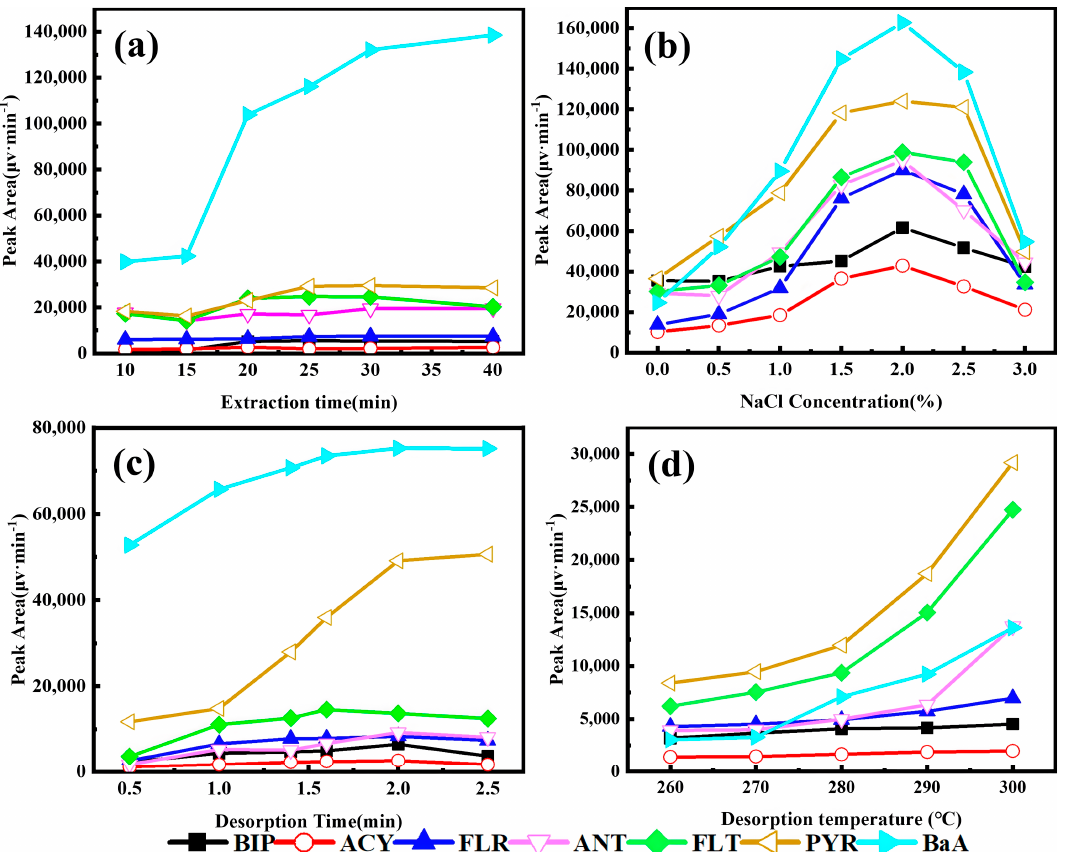
Figure 6. Effects of extraction and desorption parameters on the extraction efficiency for PAHs: ( a ) Extraction time (conditions: Desorption Time, 2 min; Desorption temperature, 300 °C; NaCl Concentration, 2%). ( b ) NaCl Concentration (conditions: Extraction time, 30 min; Desorption Time, 2 min; Desorption temperature, 300 °C). ( c ) Desorption Time (conditions: Extraction time, 30 min; Desorption temperature, 300 °C; NaCl Concentration, 2%). ( d ) Desorption temperature (conditions: Extraction time, 30 min; Desorption Time, 2 min; NaCl Concentration, 2%).